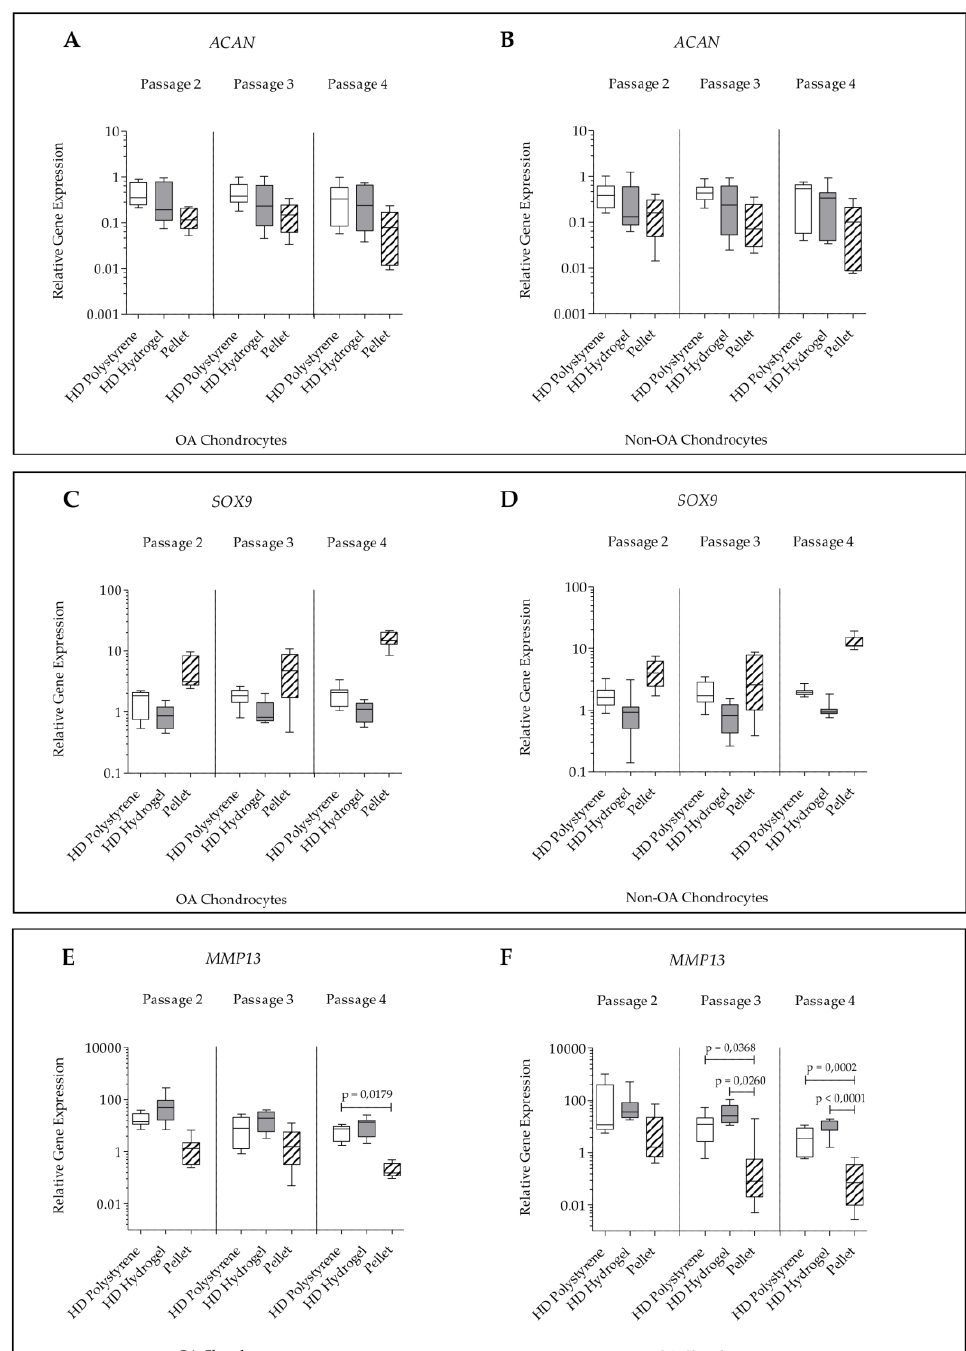
Figure 5. Relative gene expression normalized to GAPDH and day 0 (2 − ∆∆ C t ) of human articular chondrocytes after 7 days of culture in passage 2, 3, and 4 on hydrogel, on polystyrene or in pellet culture. ( A ) ACAN expression in OA chondrocytes; ( B ) ACAN expression in non-OA chondrocytes; ( C ) SOX9 expression in OA chondrocytes; ( D ) SOX9 expression in non-OA chondrocytes; ( E ) MMP13 expression in OA chondrocytes; ( F ) MMP13 expression in non-OA chondrocytes (non-OA pellet passage 2 compared to non-OA pellet passage 4: p = 0.0002).